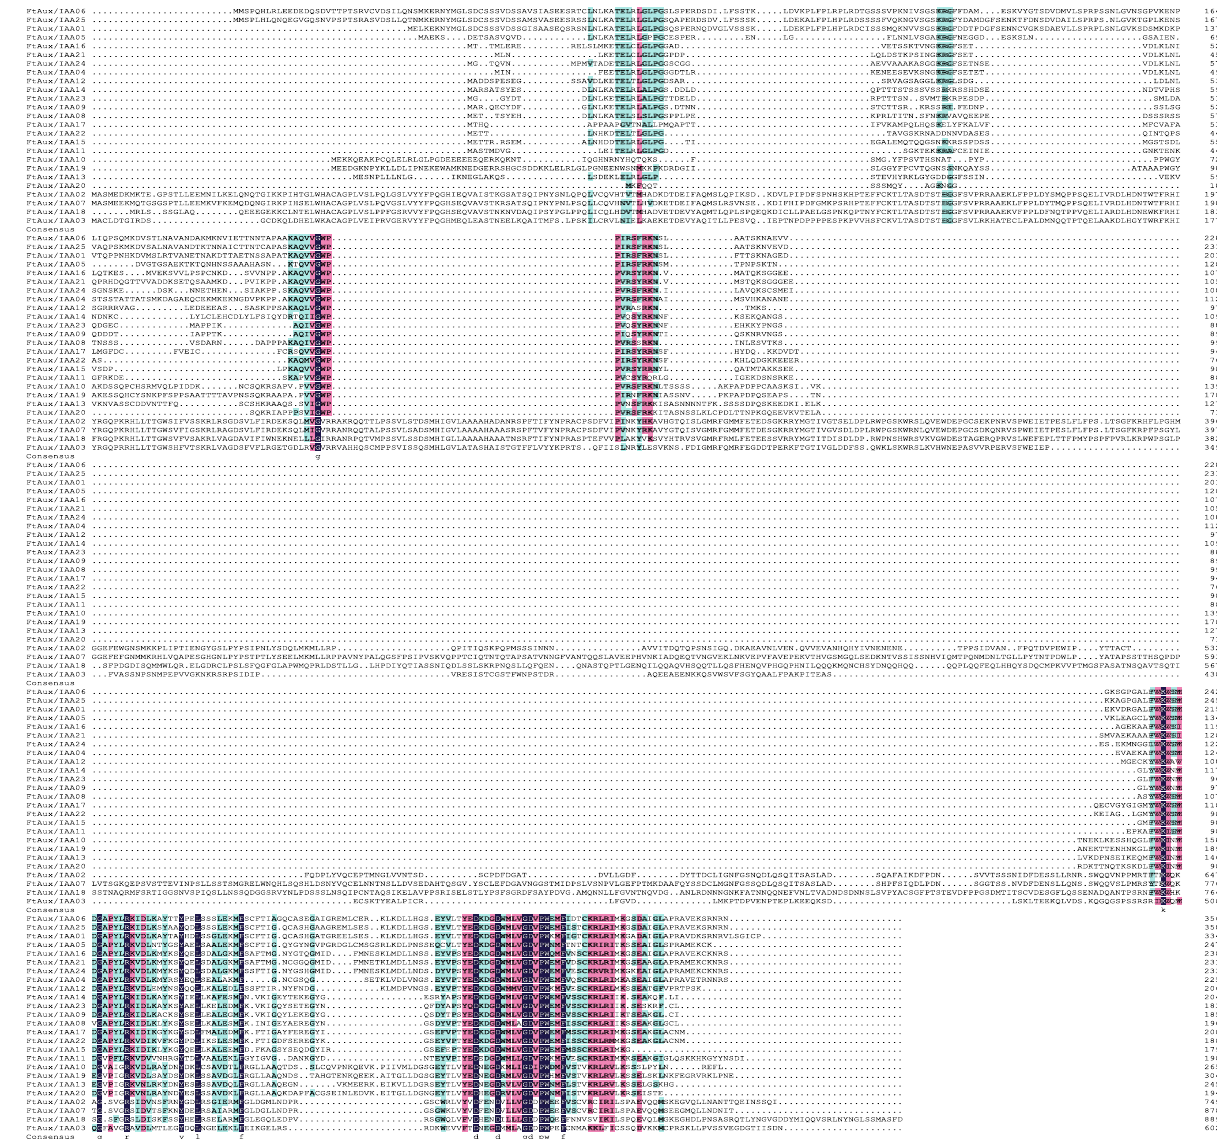
Figure 2: Multiple sequence alignment of the full-length FtAux/IAA proteins obtained with DNAMAN. Conserved domains of FtAux/IAA proteins are underlined. The gene ID is mentioned on the left of each sequence and amino acid position on the right of each